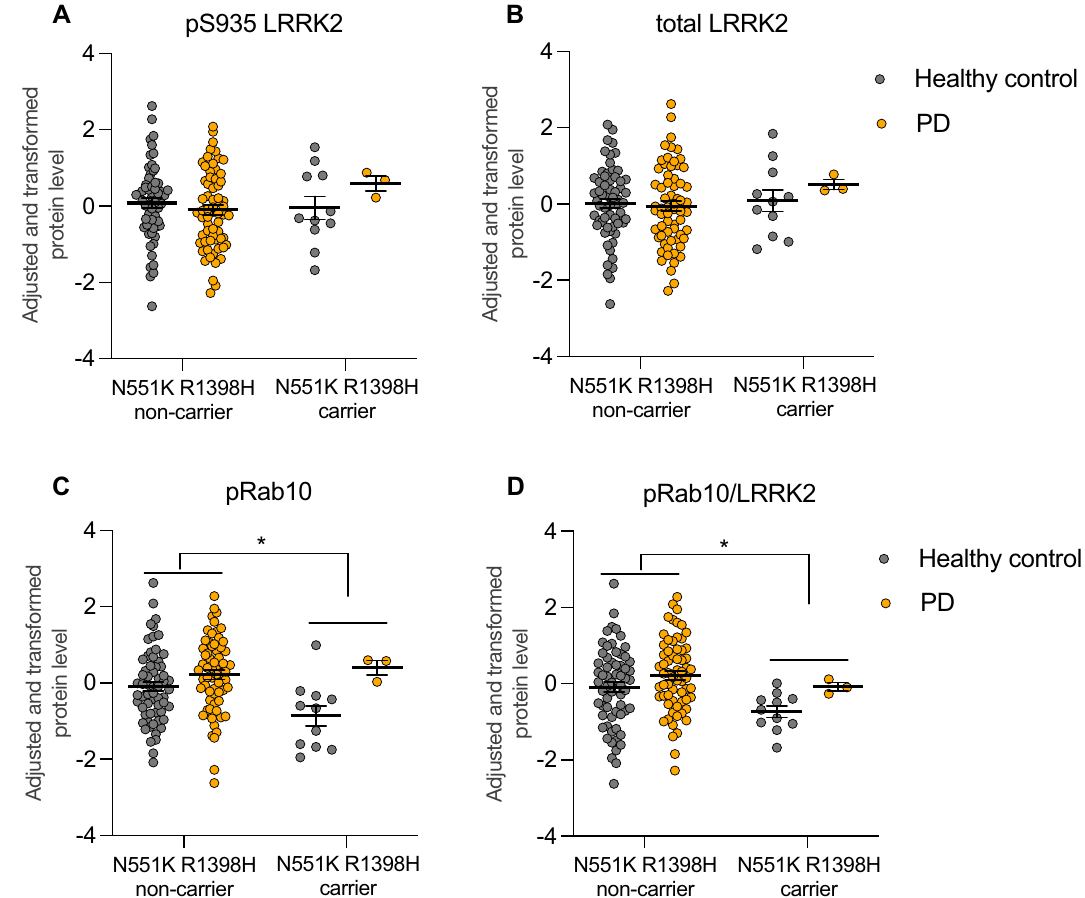
Figure 7. LRRK2 and pT73 Rab10 levels in N551K R1398H haplotype carriers and non-carriers. LRRK2, pS935 LRRK2 ( A , B ) and pT73 Rab10 levels ( C , D ) were measured in PBMCs isolated from PD and healthy subjects, and the N551K R1398H haplotype status was derived from genotype array data (n = 62 healthy control N551K R1398H non-carriers, n = 64 for PD N551K R1398H non-carriers, n = 11 for healthy control N551K R1398H carriers, and n = 3 for PD N551K R1398H carriers). Raw protein levels were natural log transformed and fit in a linear model against age, sex, and the first two principle components derived from measured genotype data to account for genetic ancestry. Residuals were then inverse normal transformed and tested for association with the N551K R1398H haplotype. Statistical analysis was performed using R version 3.6.1. ( A , B ) Levels of total and pS935 LRRK2 were comparable in N551K R1398H carriers and non-carriers; for total LRRK2, p = 0.485 and for pS935 LRRK2, p = 0.7129. ( C , D ) pT73 Rab10 (0.66 standard deviation decrease in carriers vs non-carriers) and the pT73 Rab10/LRRK2 ratio (0.66 standard deviation decrease in carriers vs non-carriers) were reduced in N551K R1398H carriers compared to non-carriers; for pT73 Rab10, p = 0.0182 and for pT73 Rab10/LRRK2, p = 0.0172. pT73 Rab10 and pT73 Rab10/LRRK2 were also significantly reduced in N551K R1398H carriers relative to non-carriers in sensitivity analyses that additionally adjusted for disease status and/or LRRK2 G2019S status; all p-values were < 0.05 with exception of pT73 Rab10/LRRK2 phenotype in "Model 4" (see “Materials and methods”), which had p = 0.053. Data shown as mean ± SEM. *p ≤